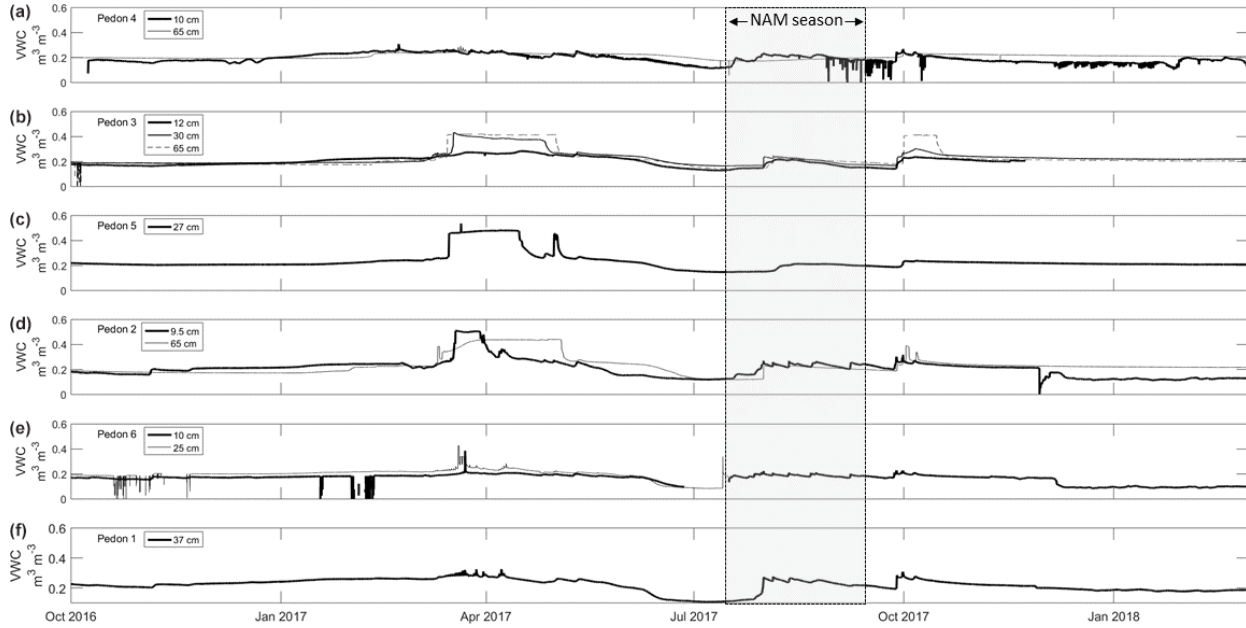
Figure 4. Volumetric water content (VWC) of six soil pedons in the ZOB. Pedons are grouped spatially with pedons 4 and 3 on the western side of the ZOB (near the site 2 wells), pedons 5 and 2 in the convergent zone (near the site 3 wells), and pedons 6 and 1 on the eastern side of the ZOB (near the site 1 wells). The shaded region marks the timing of the North American monsoon (NAM) season from 15 July through 15